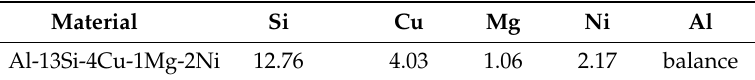
Table 2. Element content in the test alloy (wt.%).